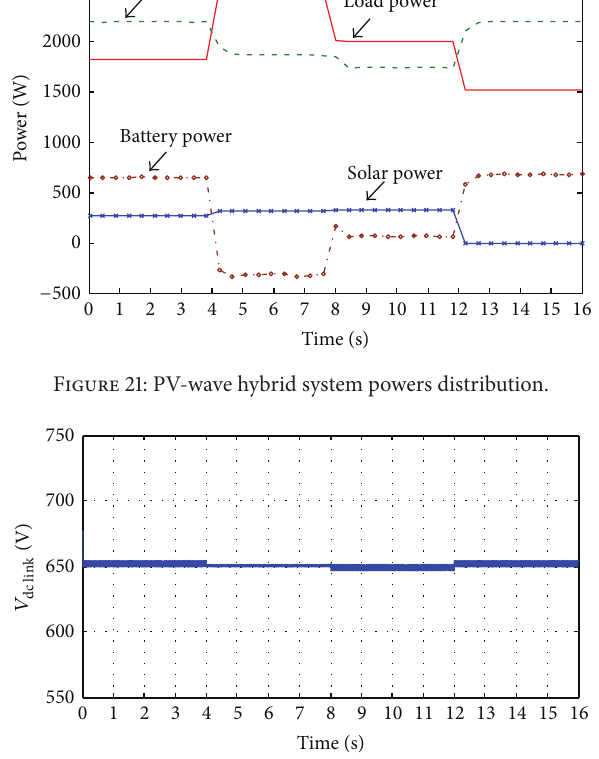
Figure 22: Dc-link